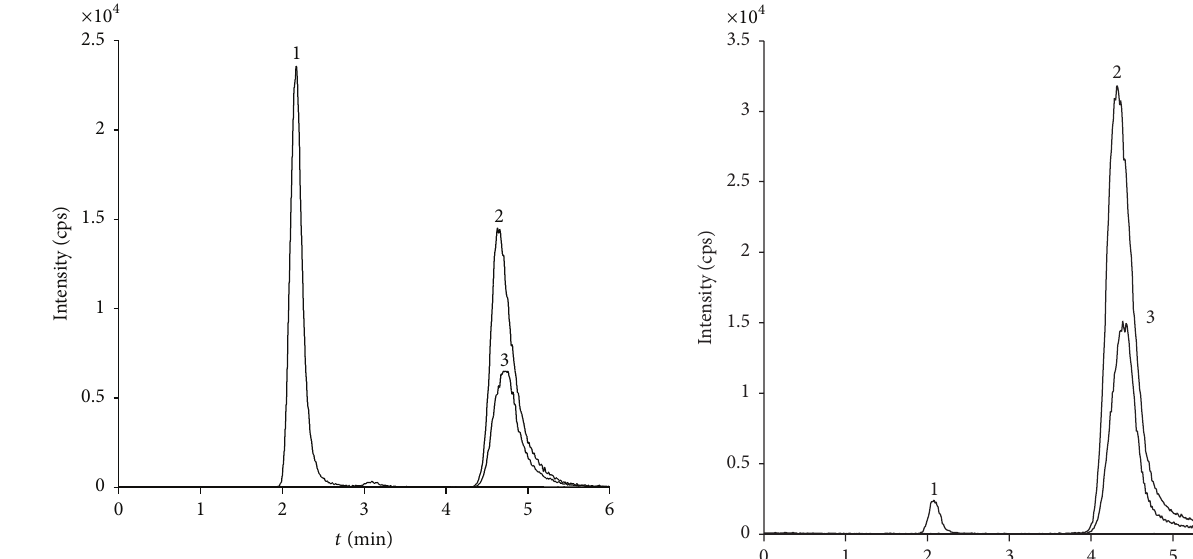
Figure 3: MRM chromatogram of a 10 𝜇 M standard solution of (1) muramic acid and (2) glucosamine (180 > 72) and (3) glucosamine (180 > 84) separated on a ZIC-HILIC column (150 × 2.1 mm, 5 𝜇 m). Figure 4: MRM chromatogram of an extracted soil sample with peaks representing m/z transitions (1) 252 → 126, (2) 180 → 72, and (3) 180 → 84. Peak areas correspond to 0.5 𝜇 M of muramic acid and 15.3 and 1.4 𝜇 M of glucosamine and galactosamine,